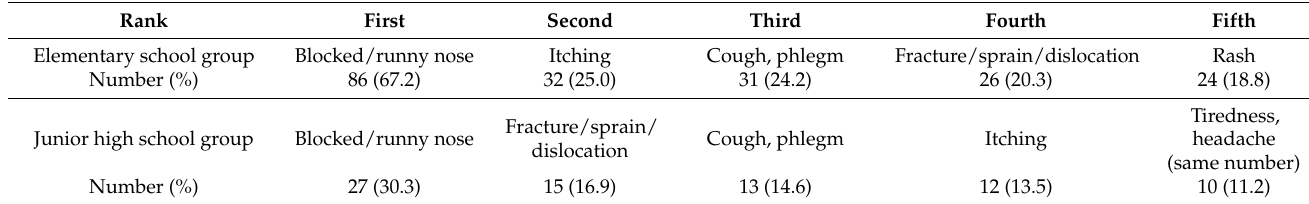
Table 3. Top five highest ranked symptoms based on proportion of responses by age